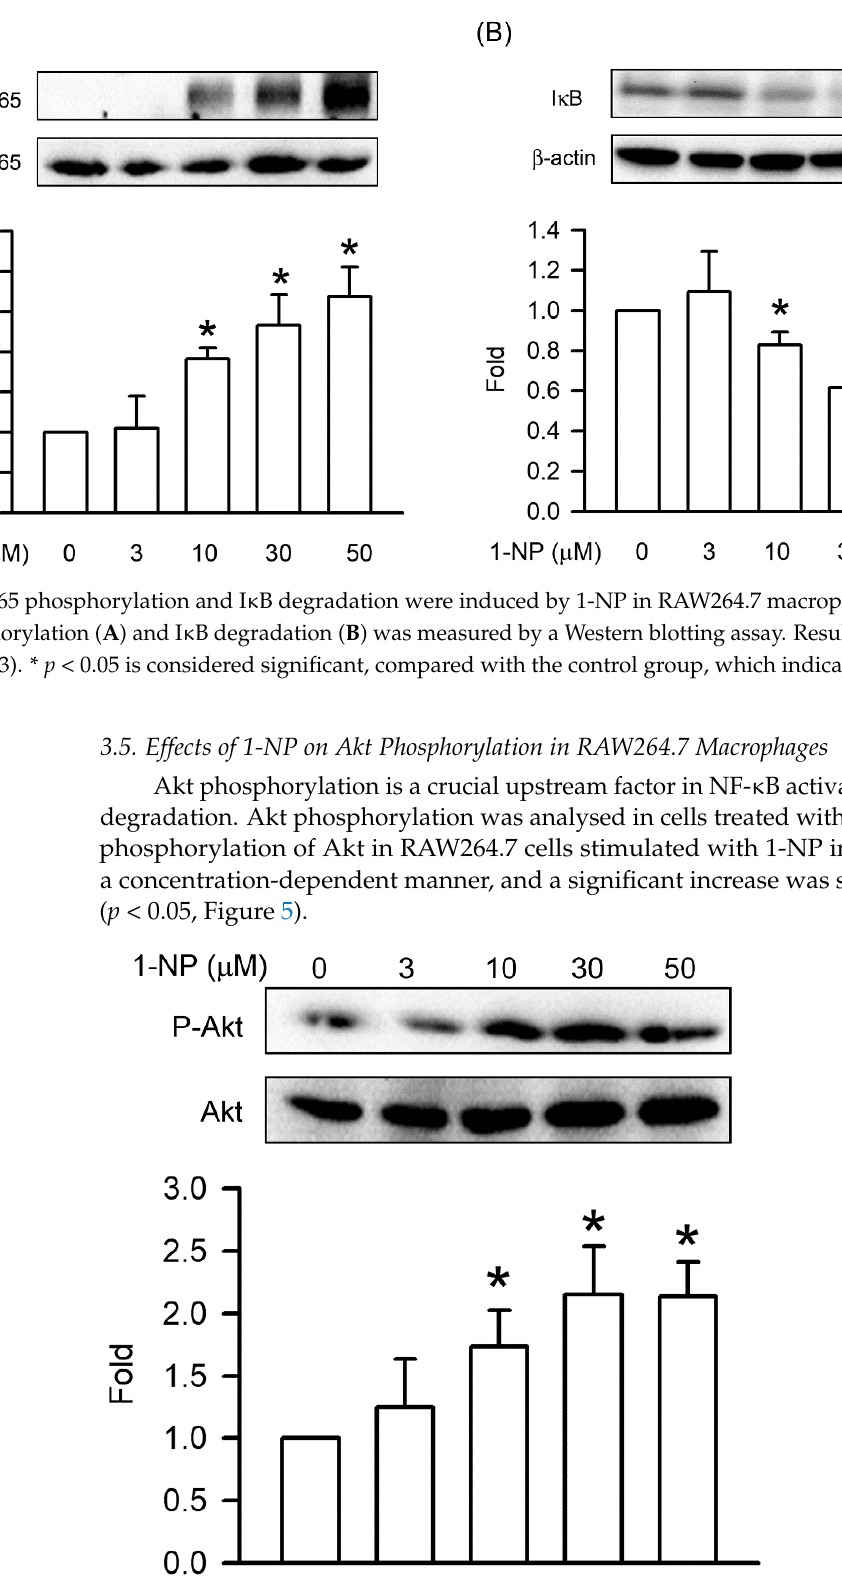
Figure 5. Akt phosphorylation was induced by 1-NP in RAW264.7 macrophages. The level of Akt phosphorylation was measured by a Western blotting assay. Results are expressed as means ± SD ( n = 3). * p < 0.05 is considered significant, compared with the control group, which indicated treatment with 1-NP at 0 μ M.